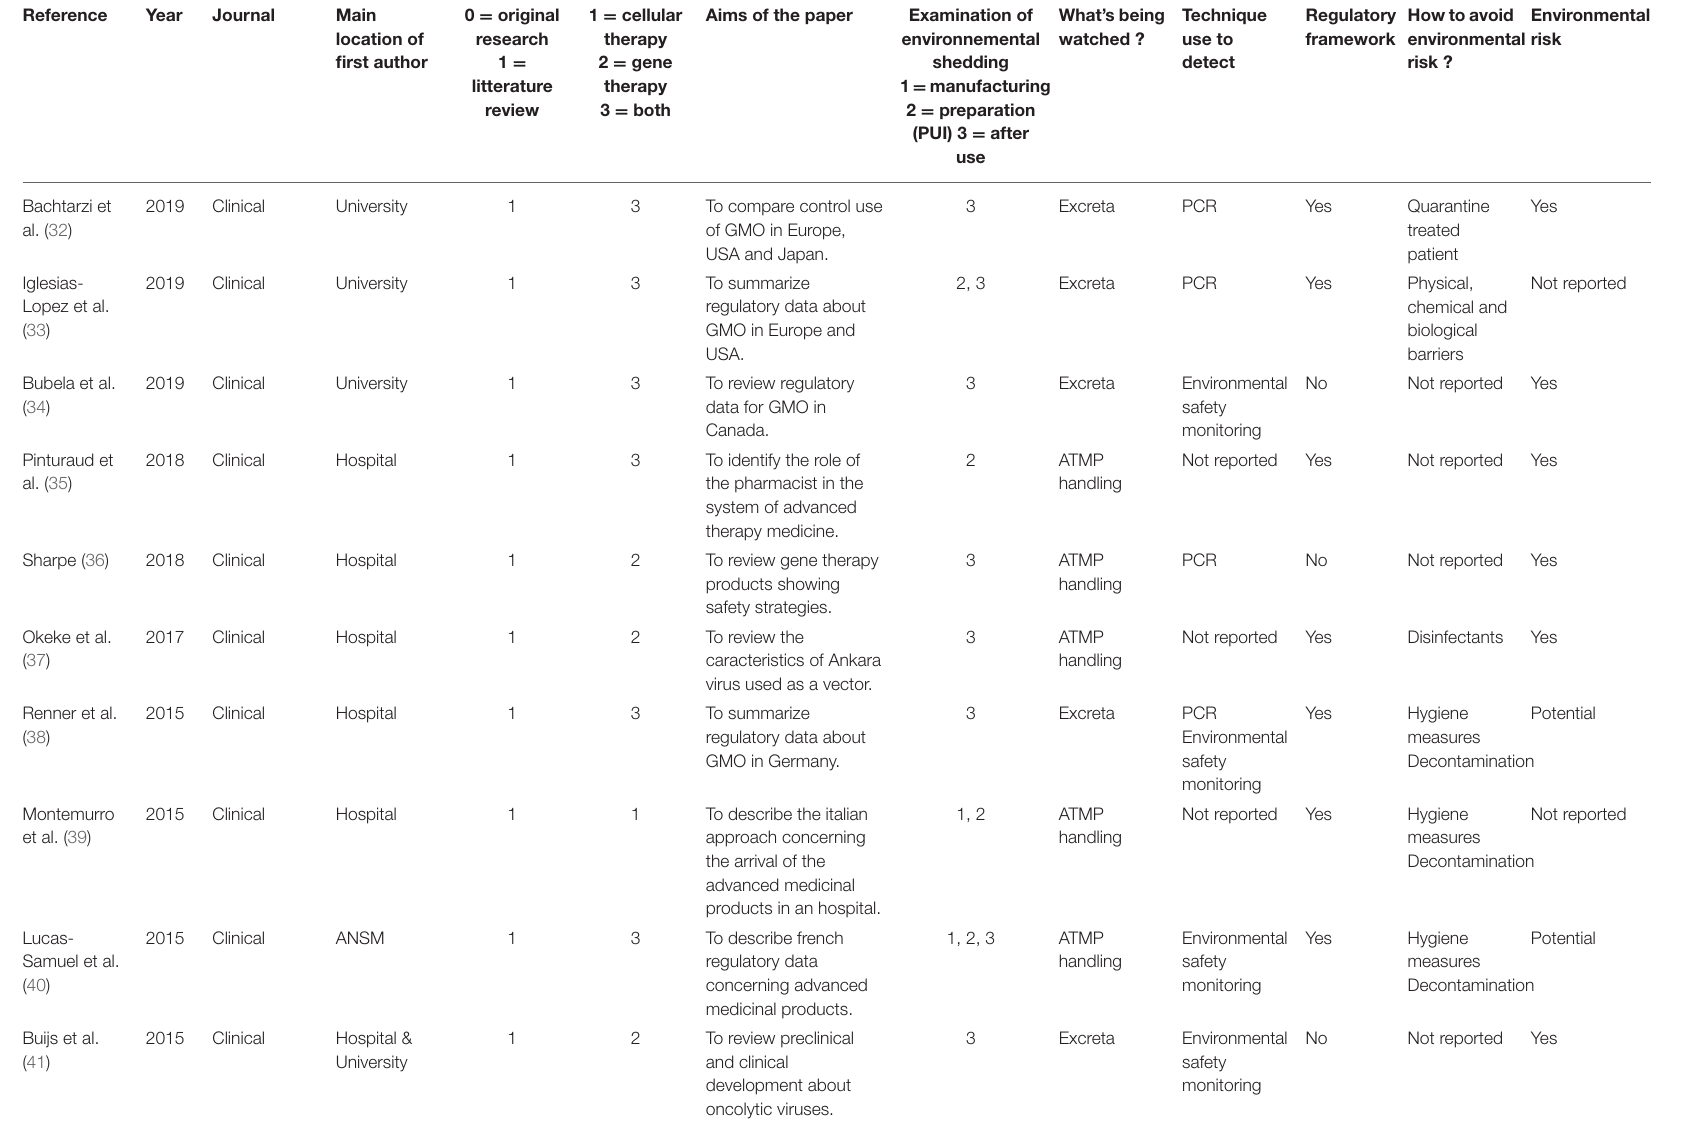
TABLE 3 | The characteristics of the 32 selected